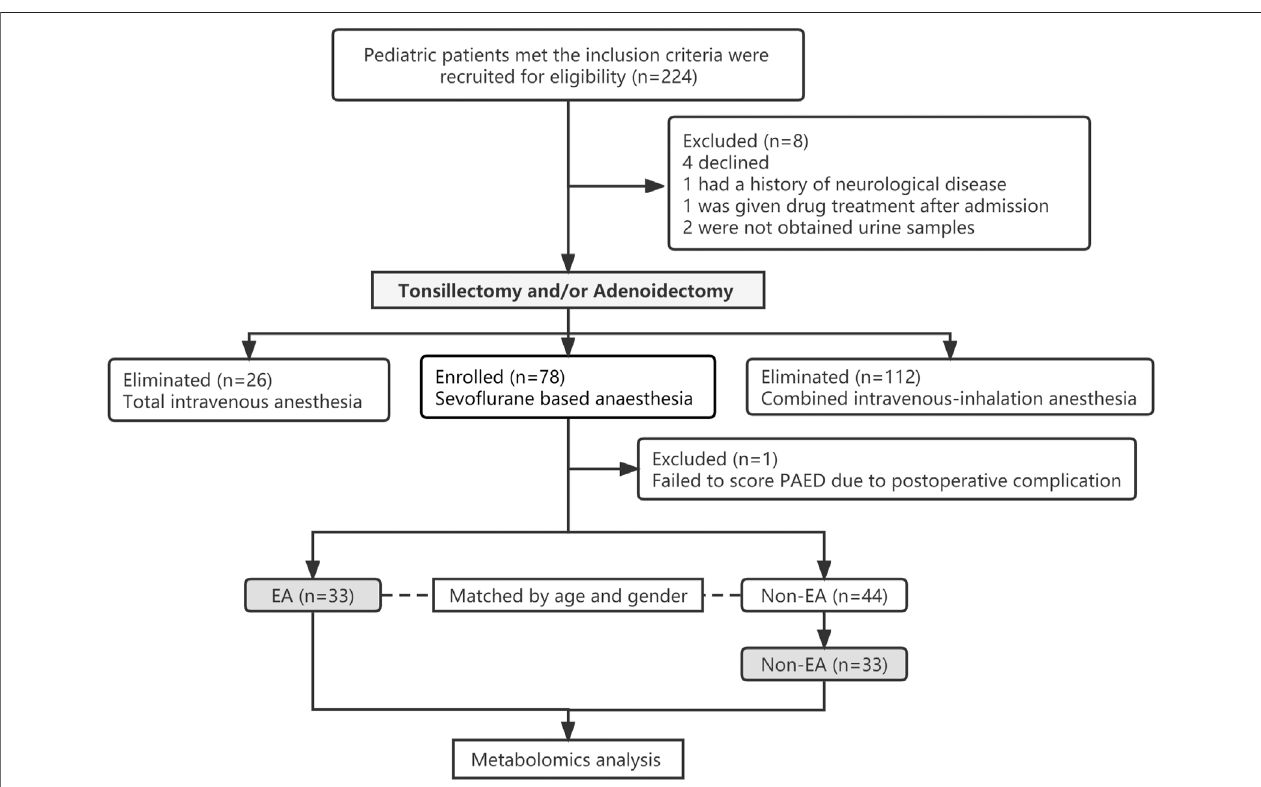
FIGURE 1 | CONSORT fl ow diagram of the